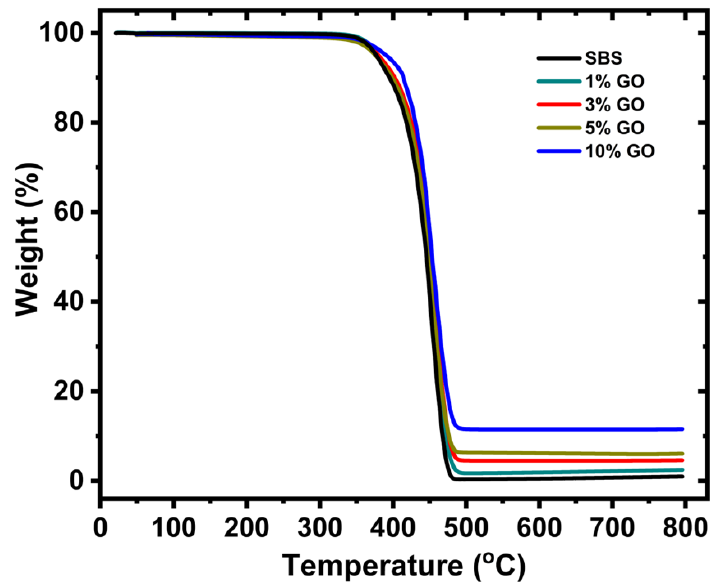
Figure 9. TGA measurements of the styrene – butadiene – styrene (SBS) composites. The GO contents according to the plateau values are in good agreement with the filler loadings which are 1, 3, 5, and 10 wt.%.